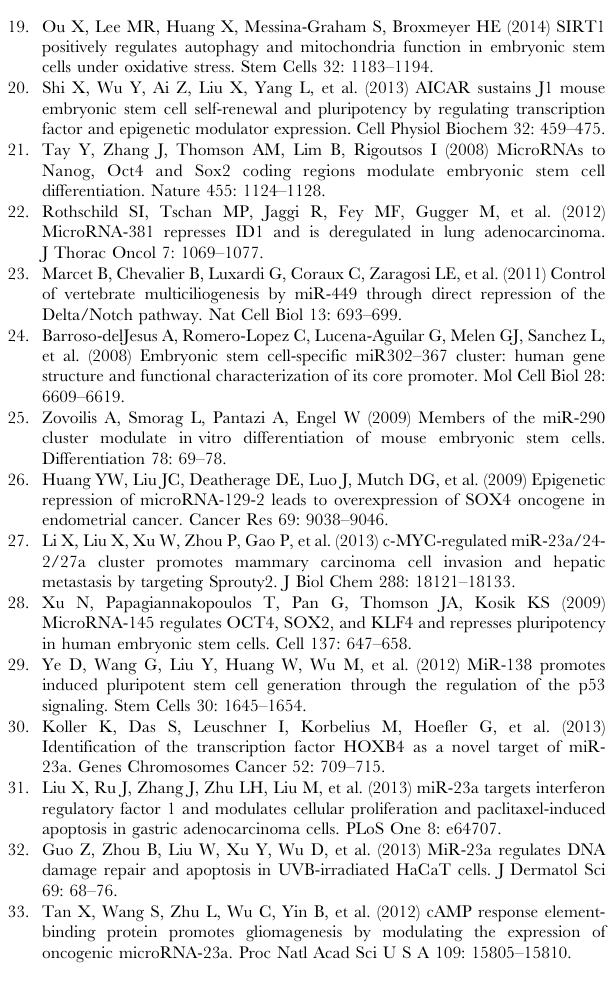
Table S1 Real-time PCR primers. List of all primers used for detection of microRNA or gene expression levels by real-time PCR. Table S2 43 microRNAs identified to be significantly down-regulated after AICAR treatment. Fold change (FC) values are provided in comparison with J1 ES cells treated by DMSO. (FC # 0.5, p # 0.01). Table S3 59 microRNAs identified to be significantly up-regulated after AICAR treatment. Fold change (FC) values are provided in comparison with J1 ES cells treated by DMSO. (FC $ 2, p #